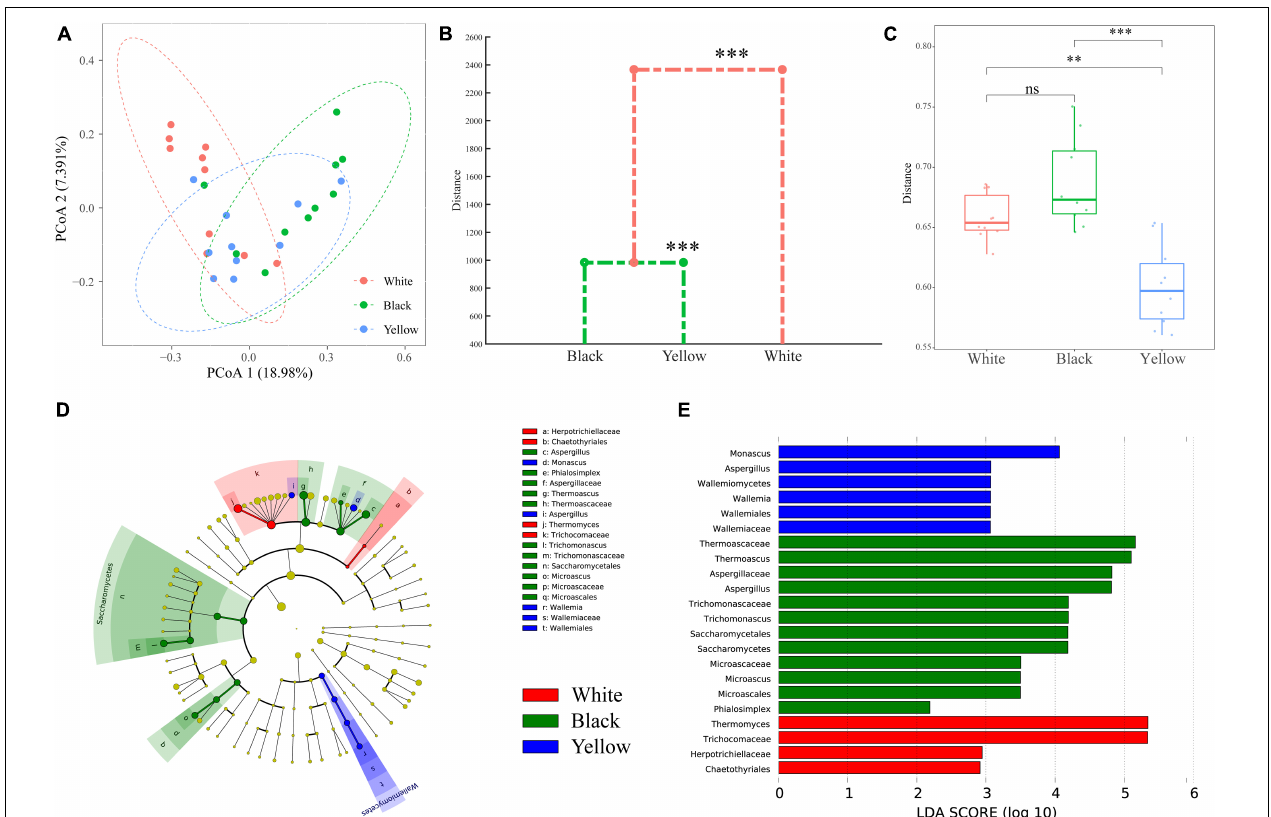
FIGURE 4 | PCoA score plots based on Bray–Curtis distance (A) ; dendrogram based on Bray–Curtis distance calculated using Mahalanobis distances and MANOVA (B) ; within-group variations of the three types of HTD calculated on the basis of Bray–Curtis distance (C) . Significant difference is represented by ∗∗∗ (0.0001 ≤ p < 0.001), ∗∗ (0.001 ≤ p < 0.01), and ns ( p ≥ 0.05), respectively. Identification of discriminant taxa among the three types of HTD by LEfSe: cladogram of the fungal communities (D) . Horizontal bar chart showing discriminant taxa (E)